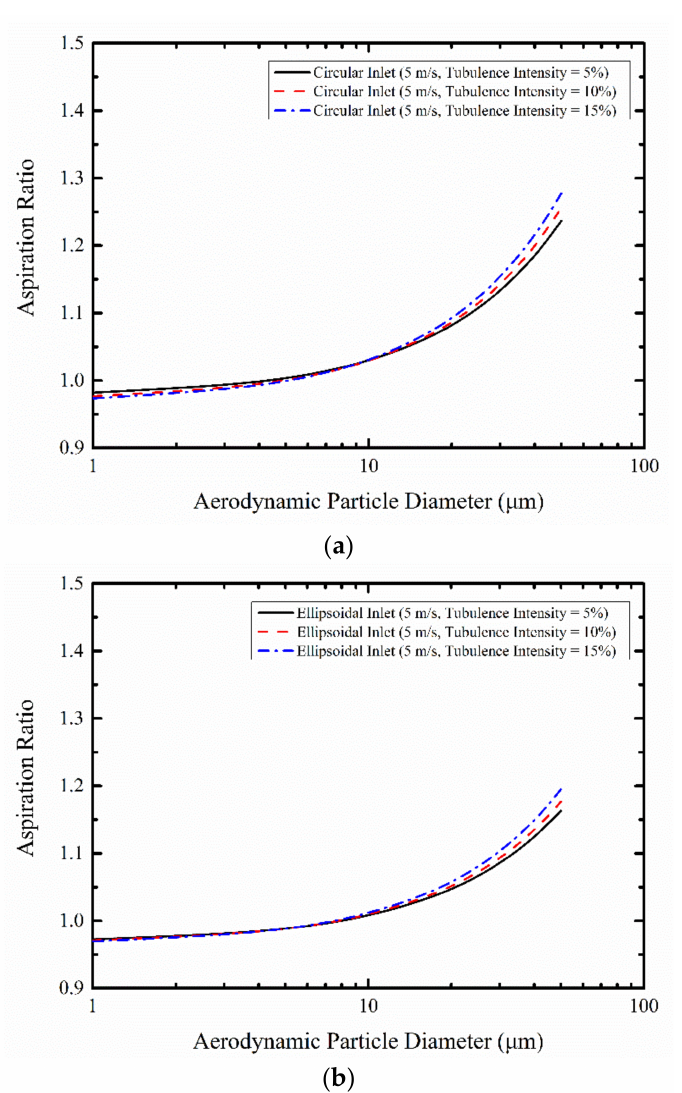
Figure 10. Comparison of aspiration ratio according to turbulence intensity: ( a ) circular inlet and ( b ) ellipsoidal